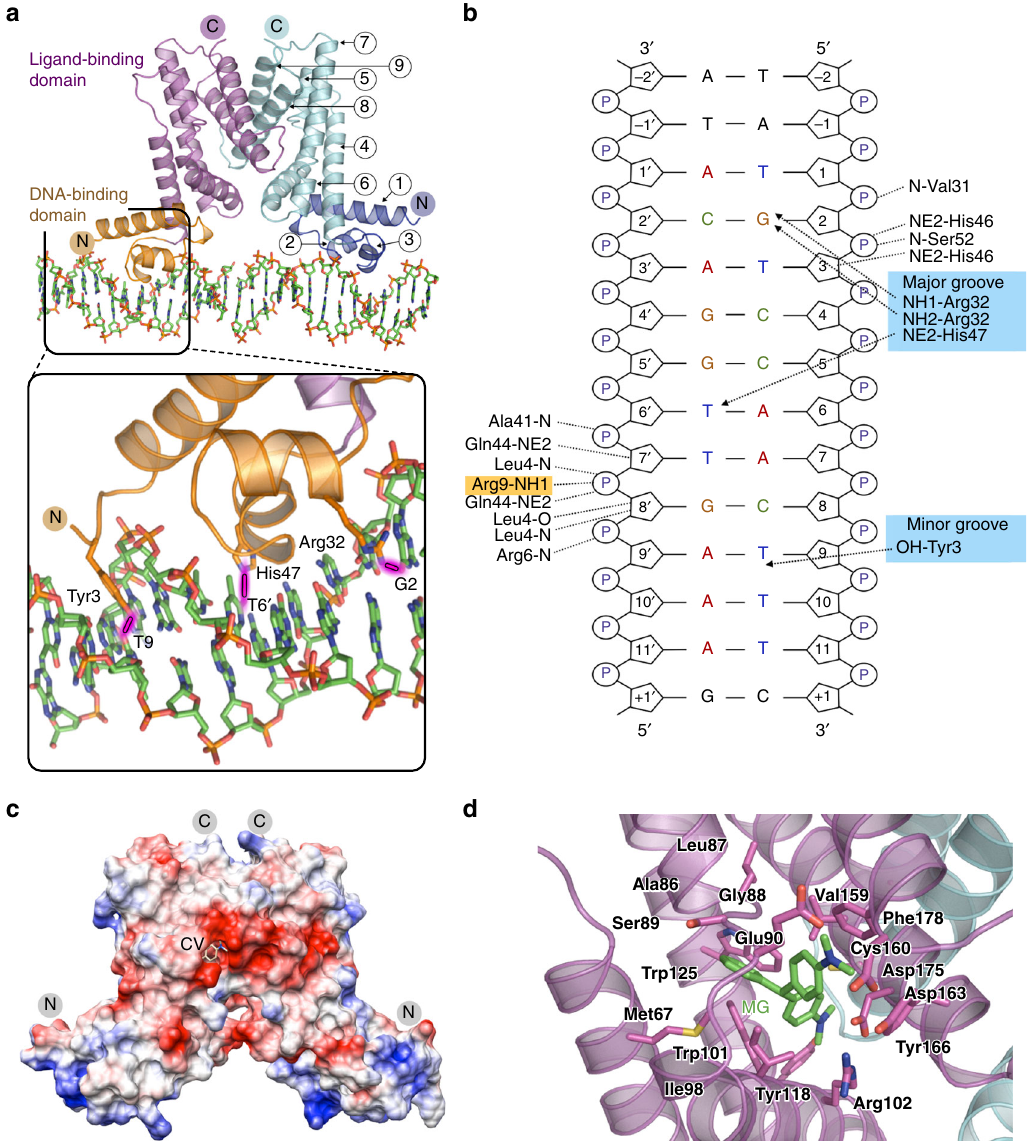
Fig. 7 The structures of the EilR- eilO and EilR-CV complexes reveal direct interactions of EilR residues with nucleotide bases and inducing ligands. a Structure of EilR with α -helices 1 – 9 bound to its operator DNA. The inset shows direct contacts of EilR-residues with nucleotide bases via hydrogen bonds: The phenolic side chain of Tyr3 interacts with the pyrimidine moiety of T 9 located in the minor groove. The basic side chains of Arg32 and His47 from the helix-turn-helix region of the DNA-binding domain contact nucleotides G 2 and T 6 ’ in the major groove. b Schematic representation of hydrogen bonds observed between the EilR monomer and a duplexed 14-bp DNA containing the 11-bp half of the palindromic consensus eilO sequence with the phospho-deoxyribose backbone. Arg9 (orange background) additionally builds a salt-bridge with a phosphate group. c An electrostatic surface representation of the repressor in complex with CV illustrates the strong negatively charged region around the ligand-binding pocket (red) and positively charged residues located in the DNA-binding domain (blue). Note that only one CV molecule is visible in this image. d EilR-binding pocket showing residues involved in electrostatic and van der Waals interactions with the inducer MG, which contacts residues Met67 in α -helix4; Ala86, Leu87, Gly88, Ser89, and Glu90 in α -helix5; Ile98, Trp101, and Arg102 in α -helix6; Trp125 in α -helix7; Val159, Asp163, and Tyr166 in α -helix8; and Phe178 in α